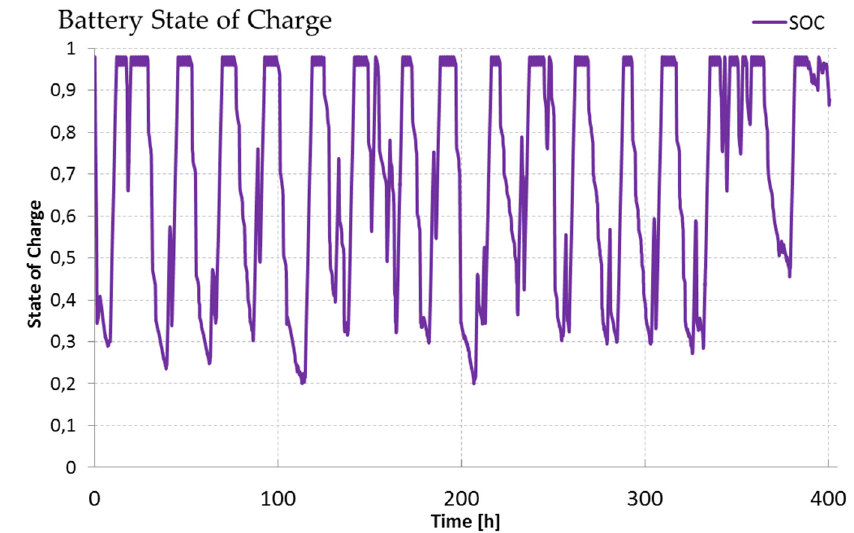
Figure 18. Plot of battery state of charge for hybrid 8p drive system.